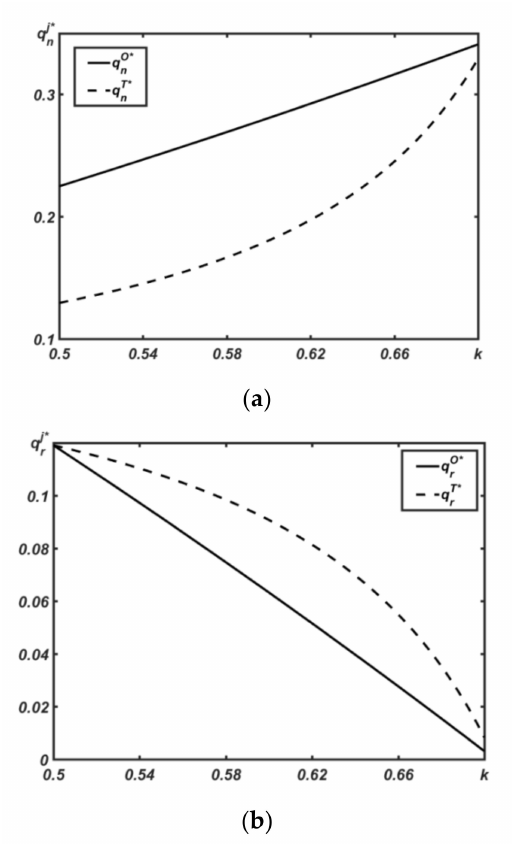
∗ n , and ( b ) variations of q